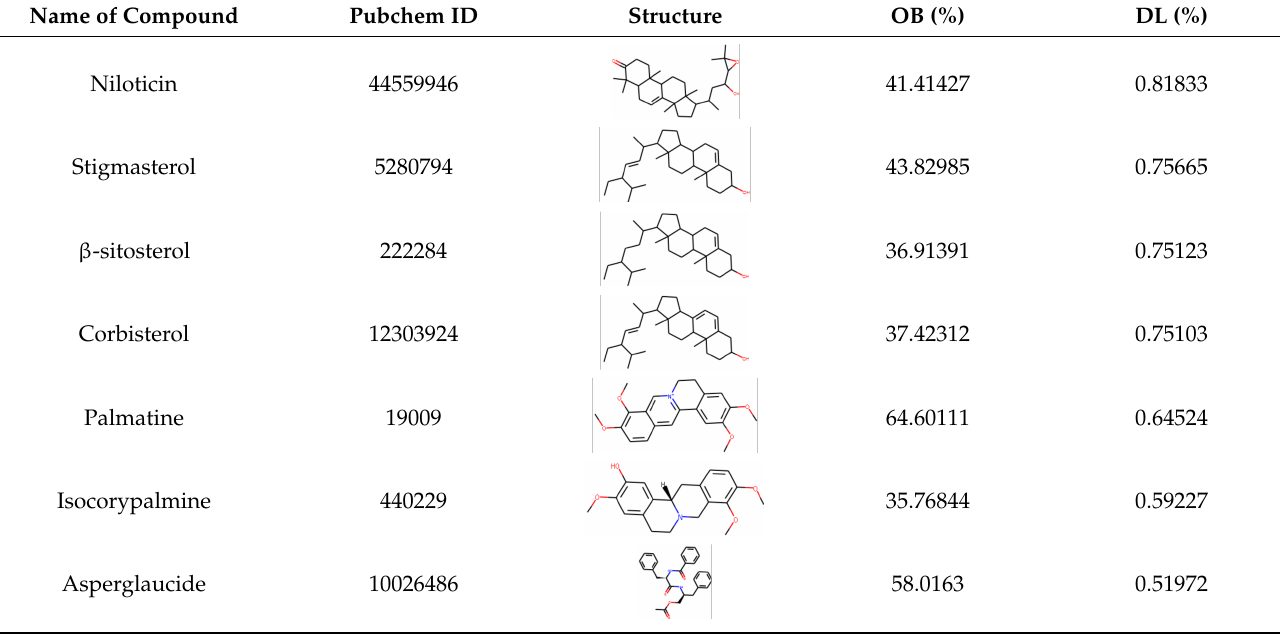
Table 1. List of compounds from Anemarrhenae rhizome and Phellodendri cortex